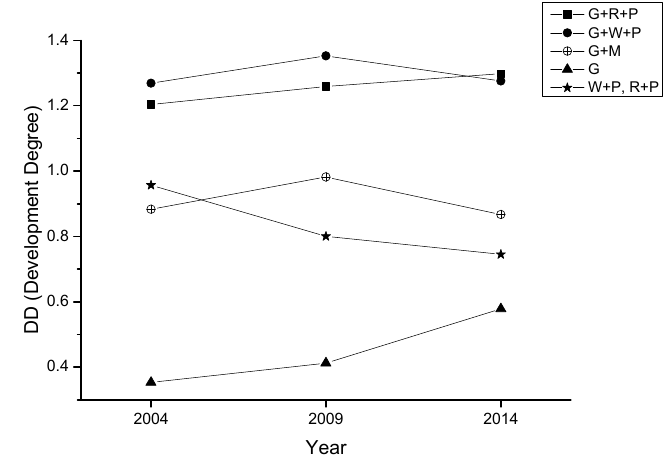
Figure 5. Development degree in three mixed Ginkgo systems, pure Ginkgo (G), and a cropping system (W+P), over three time periods.